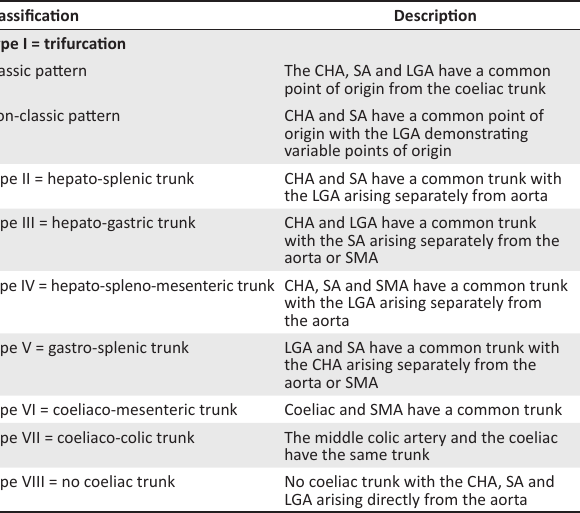
TABLE 1: Ulflacker’s